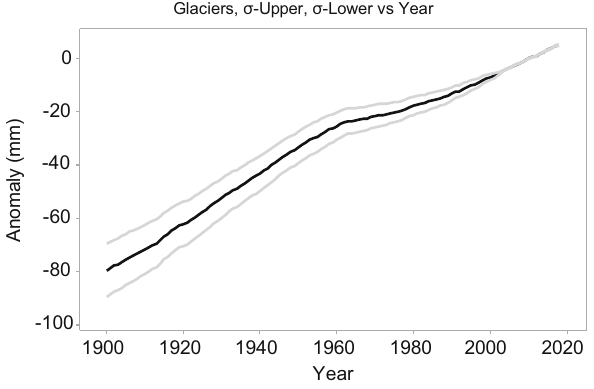
Figure 5: Yearly averaged anomalies of Antarctic component and their a priori uncertainties ( SE ) during 1900 – 2018 ( Frederikse et al. 2020 ) .